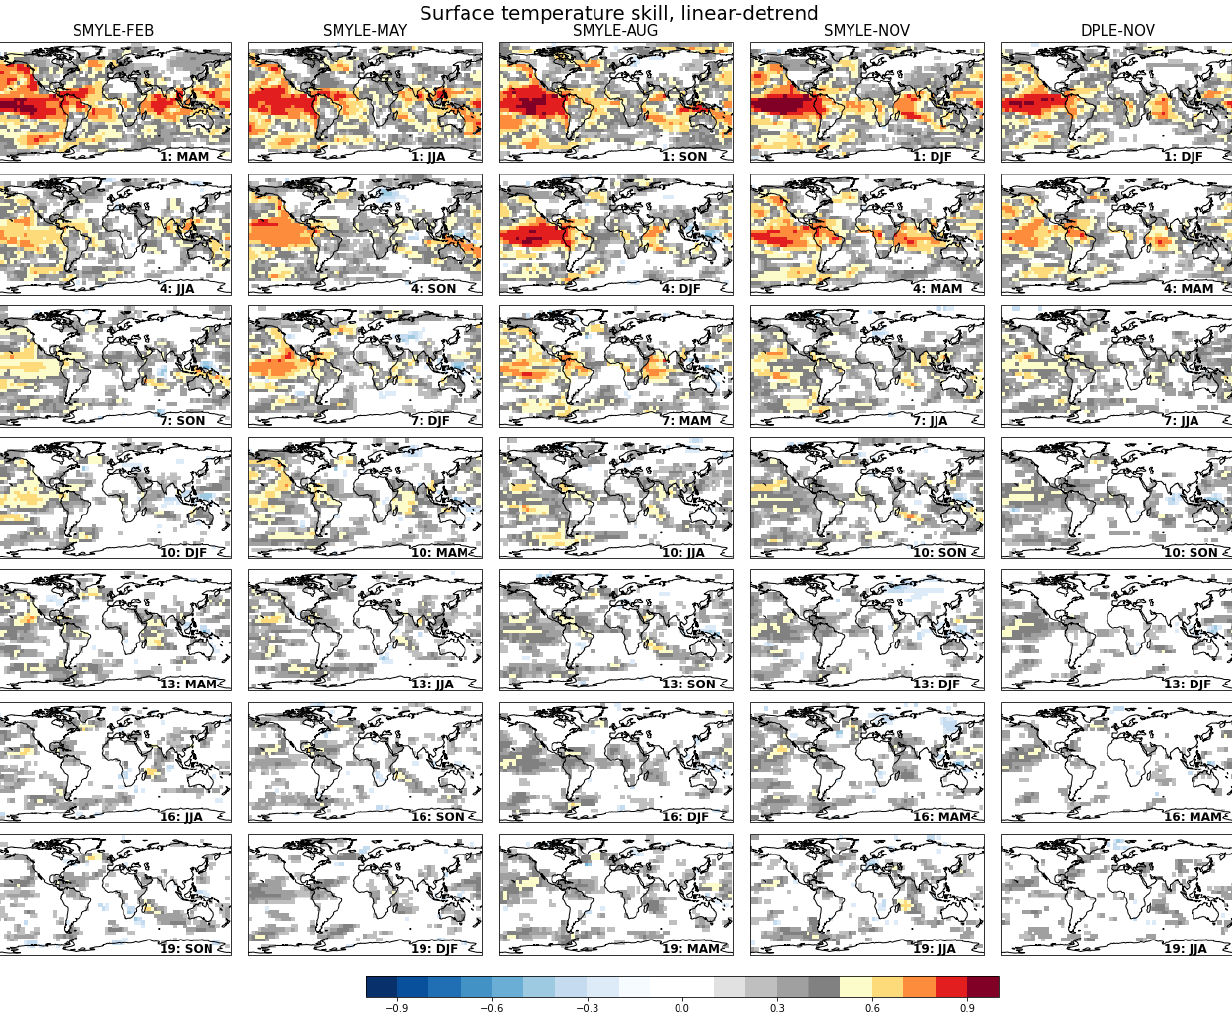
Figure 1. Anomaly correlation coefficient (ACC) for surface temperature after removing a linear trend. Columns correspond to different 20-member hindcast sets from SMYLE, with the far-right column showing 20-member DPLE results. Rows correspond to forecast season as indicated by labels that give forecast lead time and target season. Correlations are plotted only where significant ( p < 0.1). Verification is against a blend of CRU-TS4.05 (over land) and HadISST1 (over ocean) that spans 1970–2020. Figure B1 shows corresponding maps for non-detrended data, and Fig. B3 shows where SMYLE-NOV differs significantly from